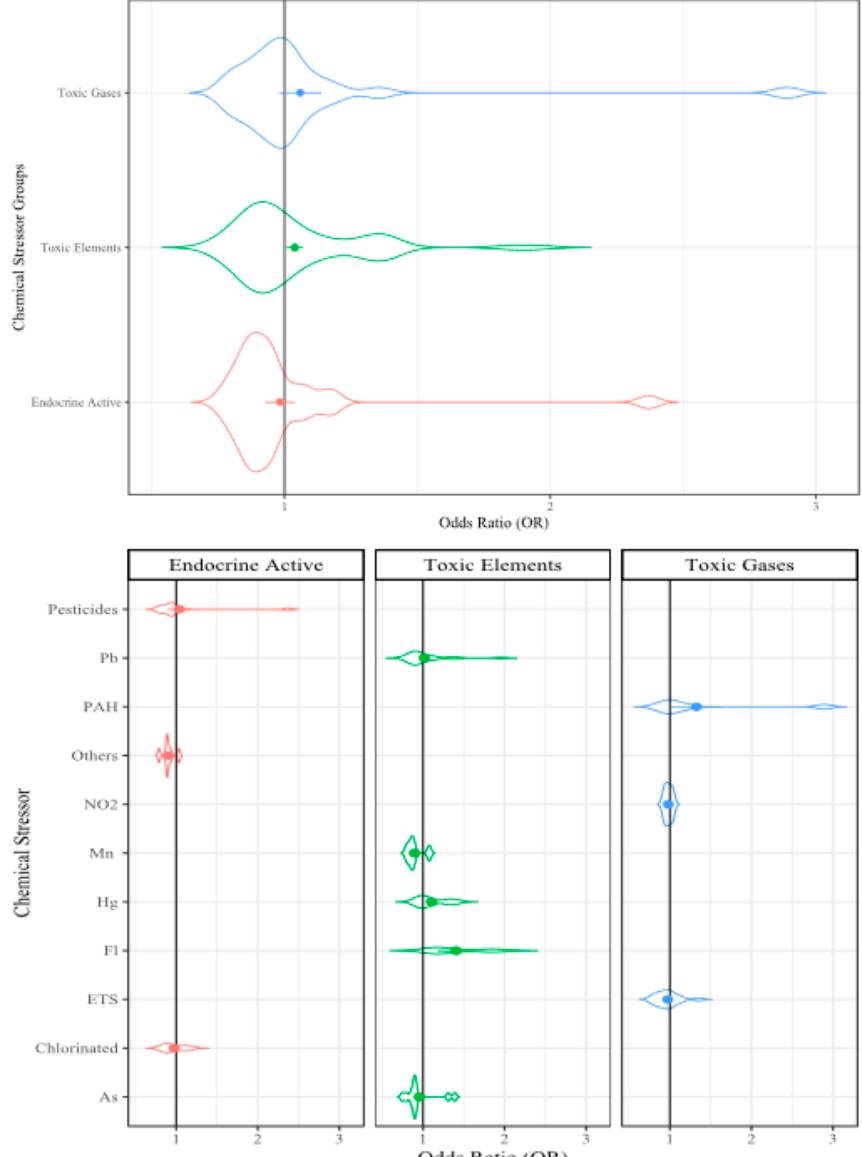
Figure 3. Violin plot of the chemical stressors that may influence cognitive development. Violin width represents the distribution of the Odds Ratios (OR), the height represents density of the ORs; dots represent mean OR, error bars represent mean SE.